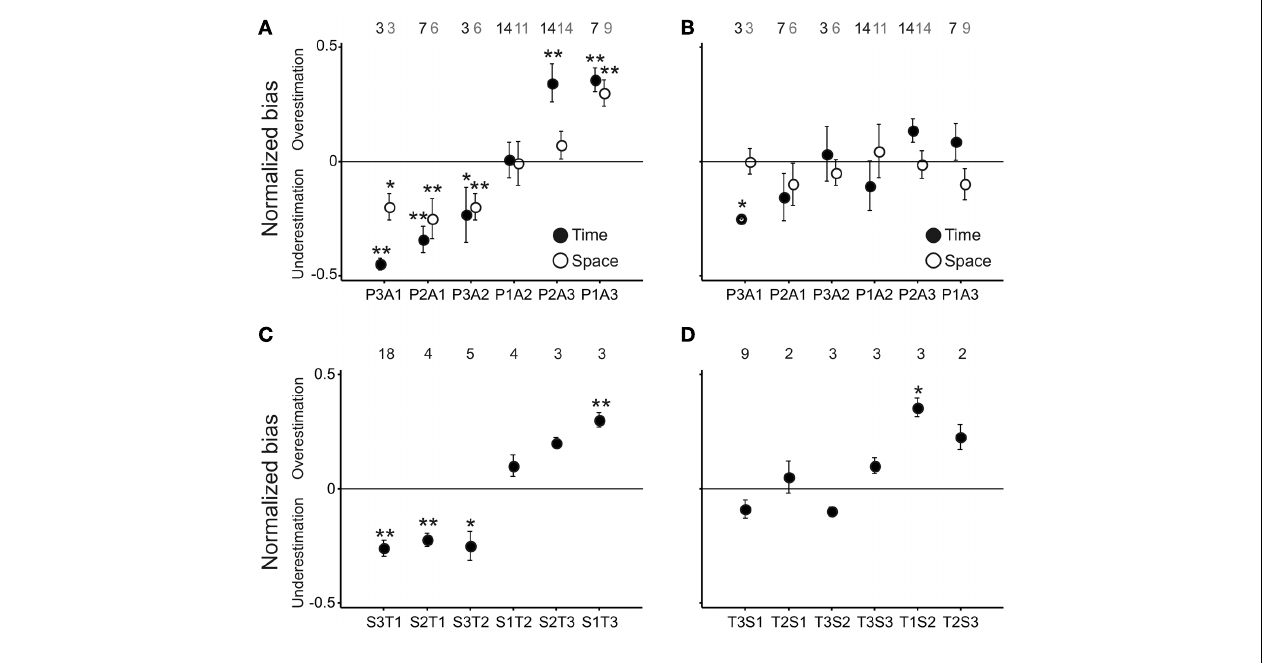
the initial 20 trials of the current block, when the current wasTCT and the previous SCT (i.e., S3–T1 corresponds to a currentT1 and a previous S3). (D) Normalized bias for the initial 20 trials of the current block, when the current was SCT and the previousTCT.The number of runs analyzed for each combination is depicted on top of each panel; for (A,B) the black and gray numbers correspond toTCT and SCT, respectively. * p ≤ 0.1, ** p ≤